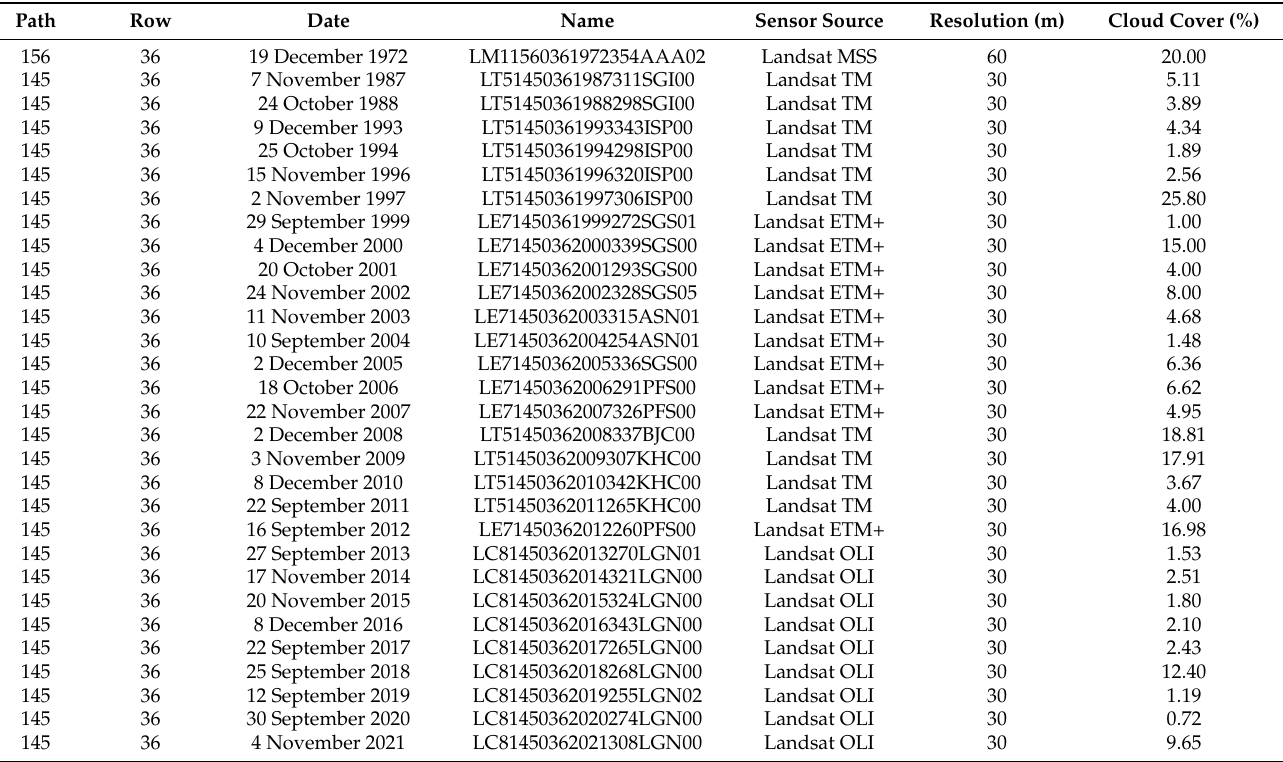
Table 1. RS data used to derive the lake